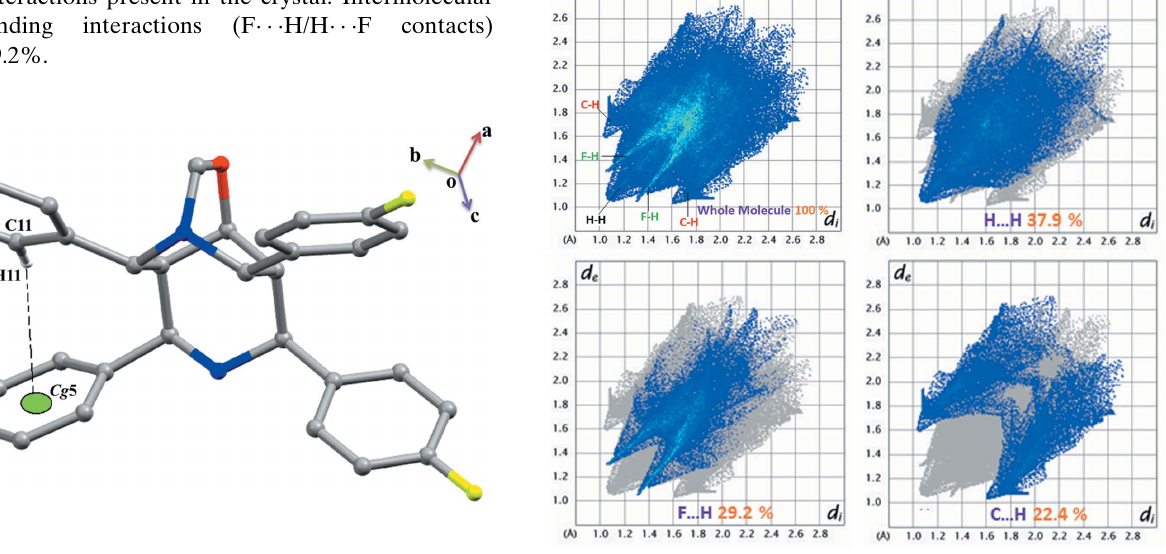
Figure 5 Two-dimensional fingerprint plots for the title